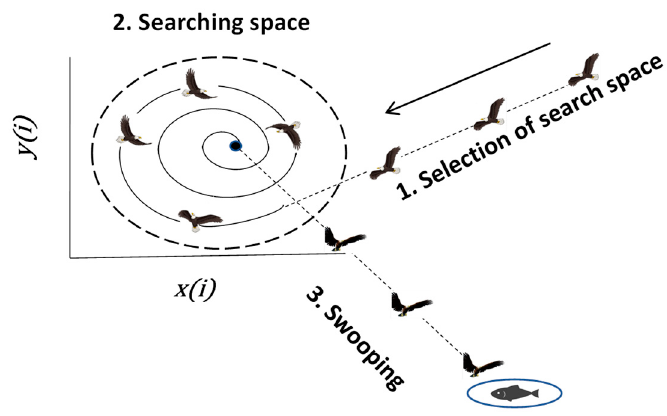
Figure 2. Hunting sequences adopted by the Bald Eagle Search.